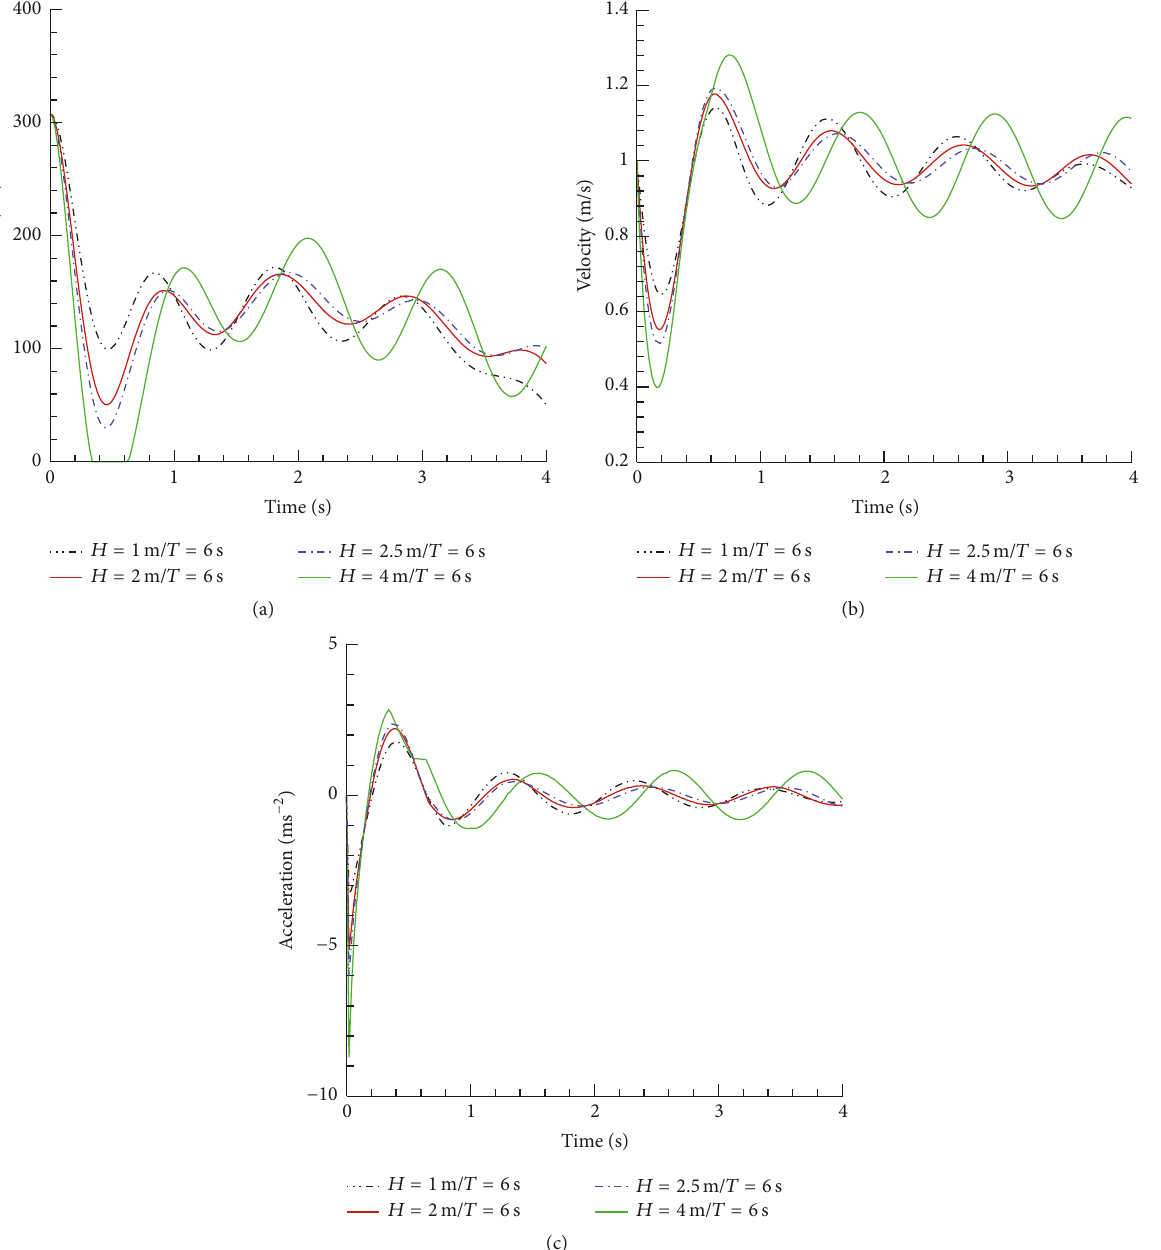
condition of the deploying cable can be observed, which is preferably